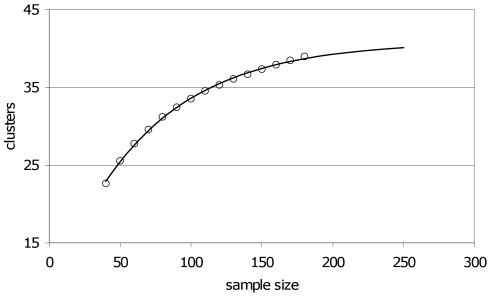
Results of the re-sampling procedure.Each data point represents the mean of 50,000 re-sampling runs. Shown is the relation between sample size and average number of realized clusters in the sample. Curve: exponential curve fitted to the data; the horizontal asymptote equals 40.9. See text for details.